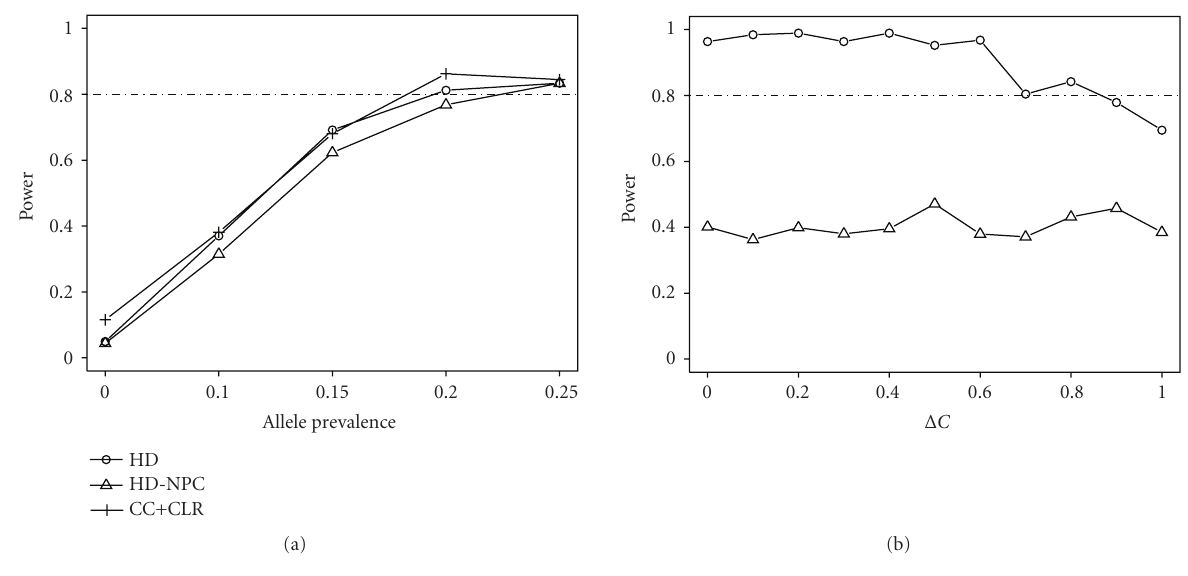
Figure 3: Power of the forward stepwise procedure to detect joint fetomaternal associations. (a) Power for the HD, HD-NPC and CC+CLR methods is shown as a function of allele prevalence for a scenario with mating symmetry and multiplicative e ff ects of both Child and Mother (Table 2, Model 4). (b) Power for HD and HD-NPC is shown as a function of departure from mating symmetry, as measured by Δ C , for a scenario with mating asymmetry and multiplicative e ff ects of both Child and Mother (Table 2, Model 8). Allele prevalence is set at q = 0 . 3. MA models (9 mating-type parameters) were used for log-linear regression under the assumption of mating asymmetry. Horizontal reference lines indicate power = 0.8. HD, hybrid design using parents of controls in a log-linear framework; HD-NPC: log-linear analysis using unrelated controls rather than their parents; CC+CLR: combined case-control and conditional logistic regression